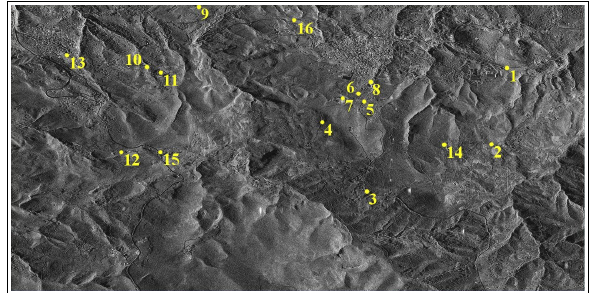
Figure 8. CPs distribution.